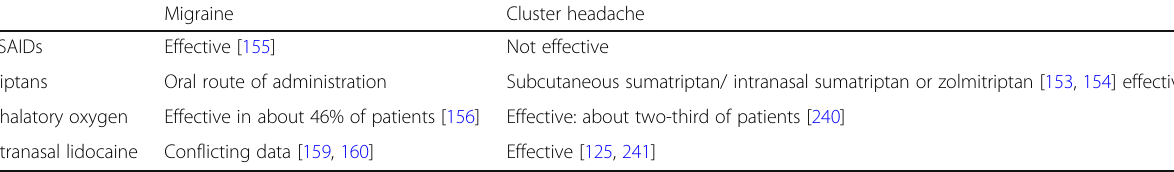
Table 4 Efficacy of acute therapies in migraine and cluster